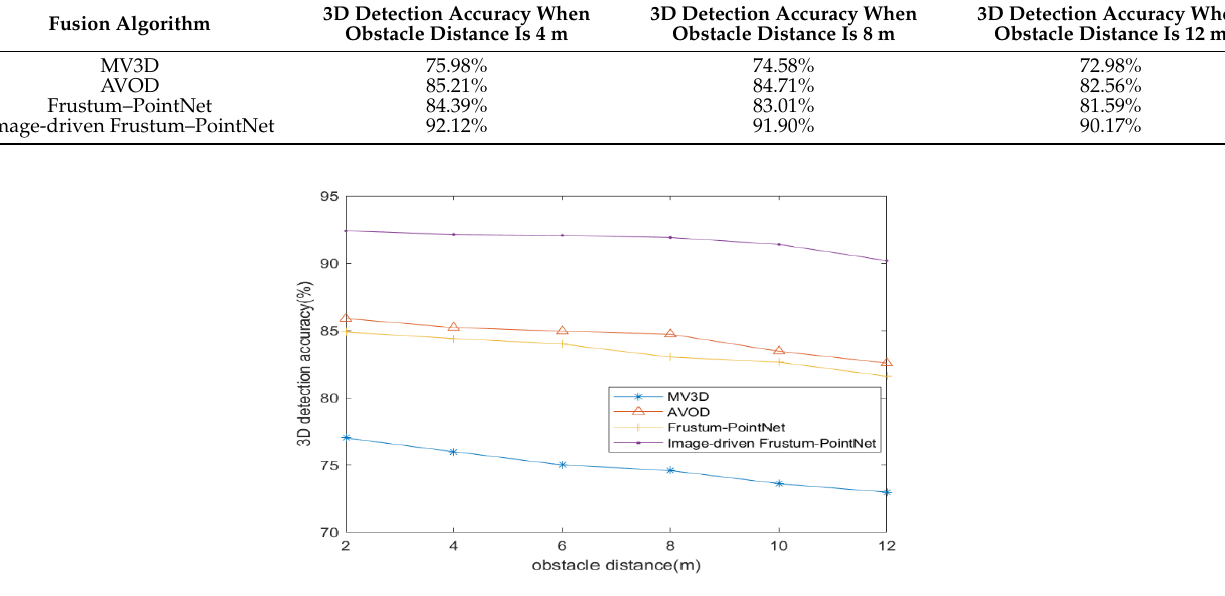
Figure 25. Relationship between 3D detection accuracy and distance.